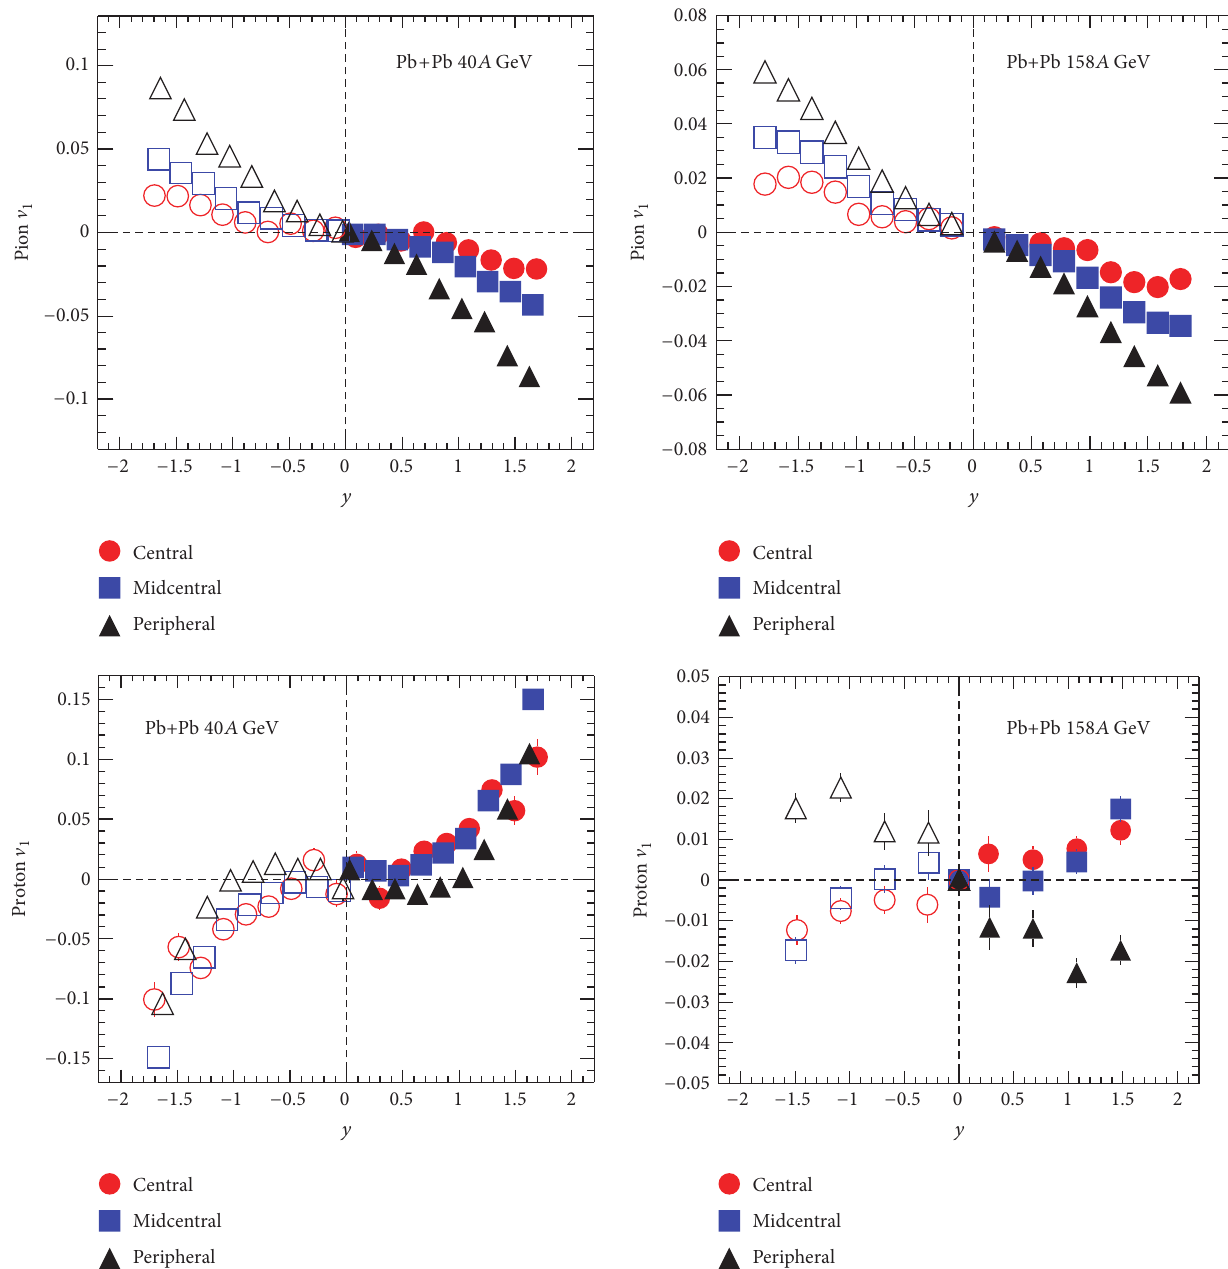
Figure 8: Pion and proton V 1 (𝑦) for three centralities in 40 𝐴 and 158 𝐴 GeV Pb+Pb collisions at the SPS [40]. The open markers at negative rapidity were obtained by reflecting the solid markers at positive rapidity, where the detector acceptance was optimum.